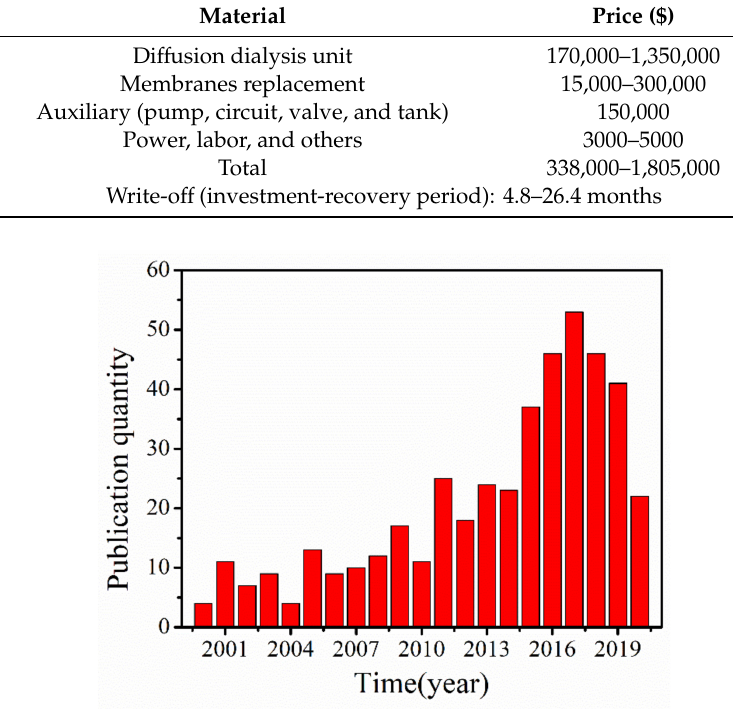
Figure 2. Chronology of di ff usion dialysis using anion exchange membranes for acid recovery documents